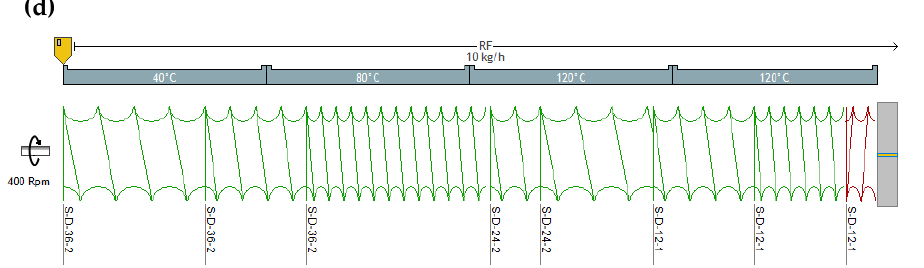
Figure A2. Illustration of extruder screw profiles for manufacturing of ( a ) Expanded sample from maize starches having different amylose content [27,33] and potato starch [31]. For potato starch, two cylindrical dies in parallel were used, ( b ) Dense sample from potato and pea starches [32] and expanded samples from fava bean flour and starch concentrate, and from blends of tapioca, Empure and Merizet starches, ( c ) expanded snacks from pea flour [34] and breakfast cereals products. For pea flour, the presented extruder was equipped with a cylindrical die only. ( d ) Expanded snacks from bran-enriched wheat flour [35,36]. All screw representations were build-up using Ludovic ® software according to description given in the